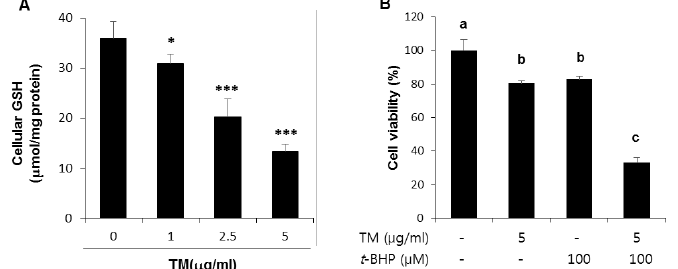
Figure 6. Effect of TM treatment on the cellular level of GSH, and potentiation of oxidative cell death by the pre-exposure of TM in HepG2 liver cells. ( A ) Cellular levels of GSH at 24 h after treatment with the indicated concentration of TM. ( B ) Cells were exposed to 5 µg of TM for 24 h before treatment with 300 µM of tert-butyl hydroperoxide ( t -BHP) for 6 h, followed by an MTT assay. Each value represents the mean ± SD. * and *** Statistically significant difference from vehicle treated cells indicated by “TM 0” at p < 0.05 and < 0.001, respectively (Student’s t -test). Values with different letters are significantly different from one another (ANOVA followed by Newman-Keuls multiple range test p < 0.05).